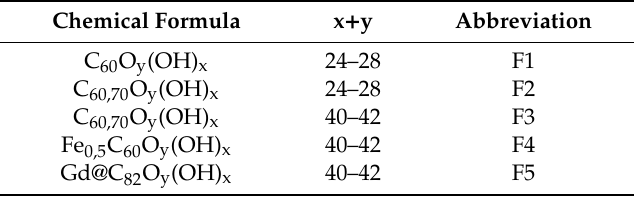
Table 1. Fullerenol’ chemical formulas and short